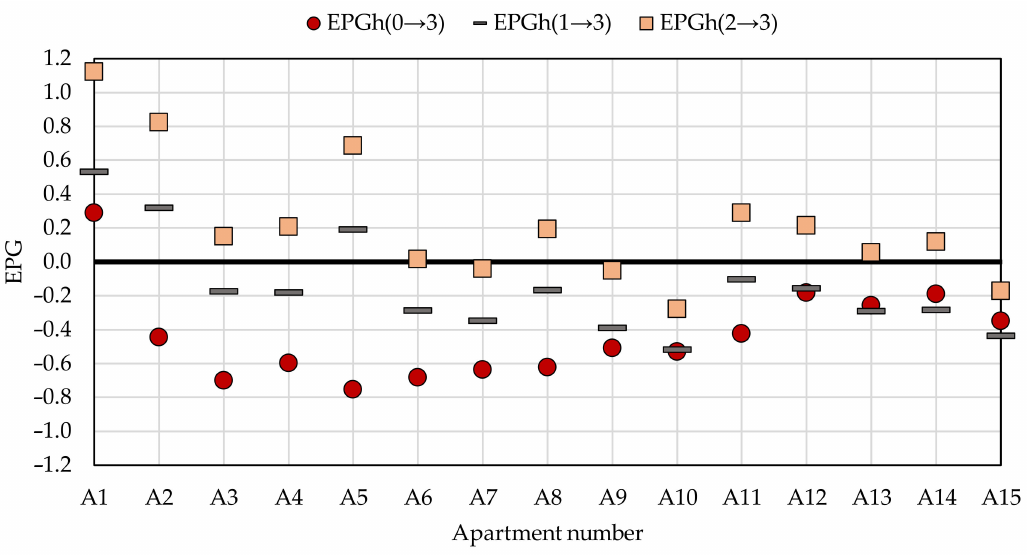
Figure 6. Energy performance gap for space